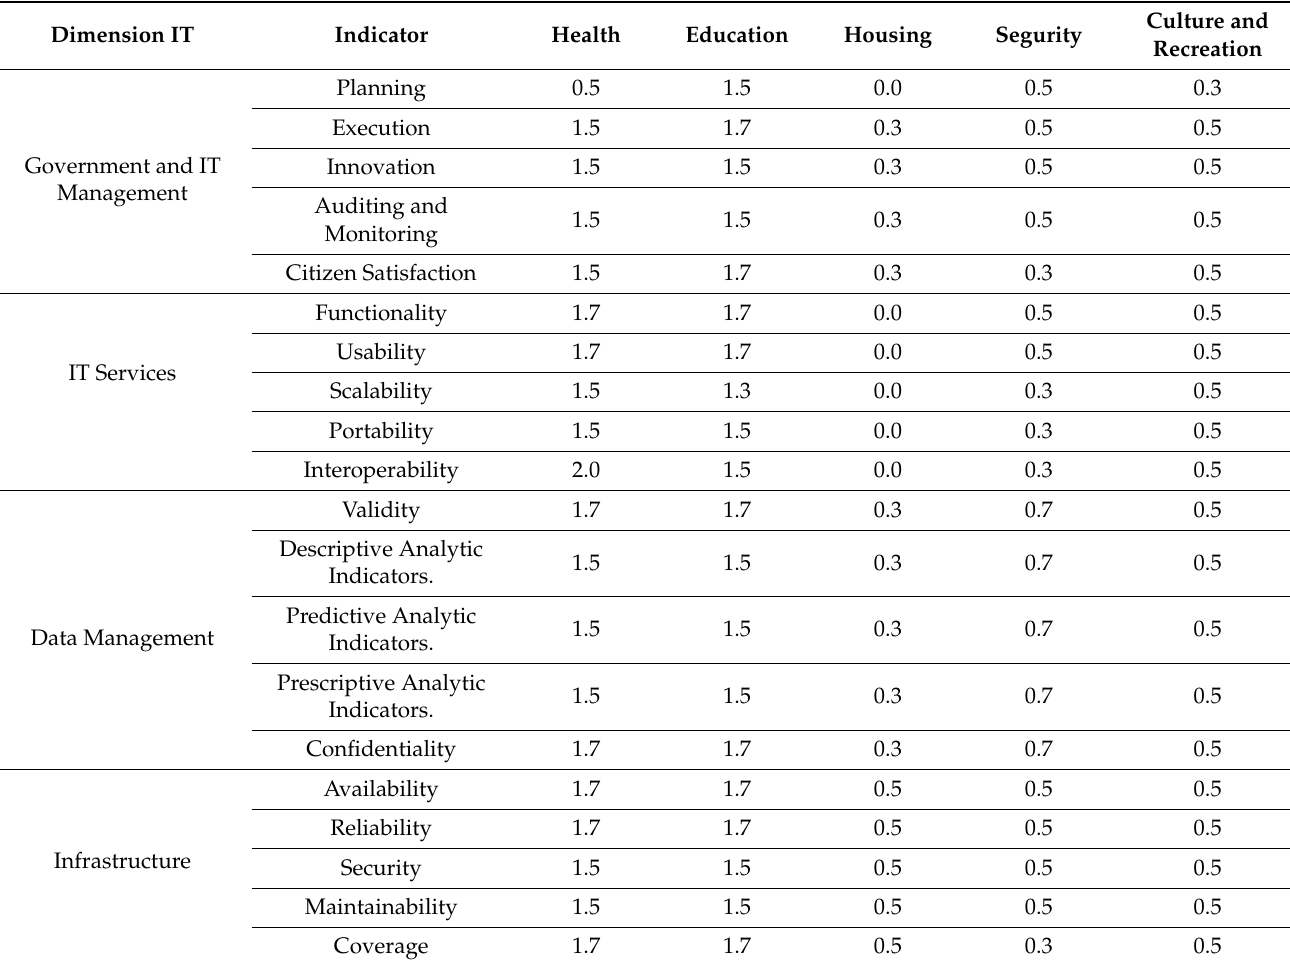
Table 11. Step 2c: Determine the level of maturity for each indicator.